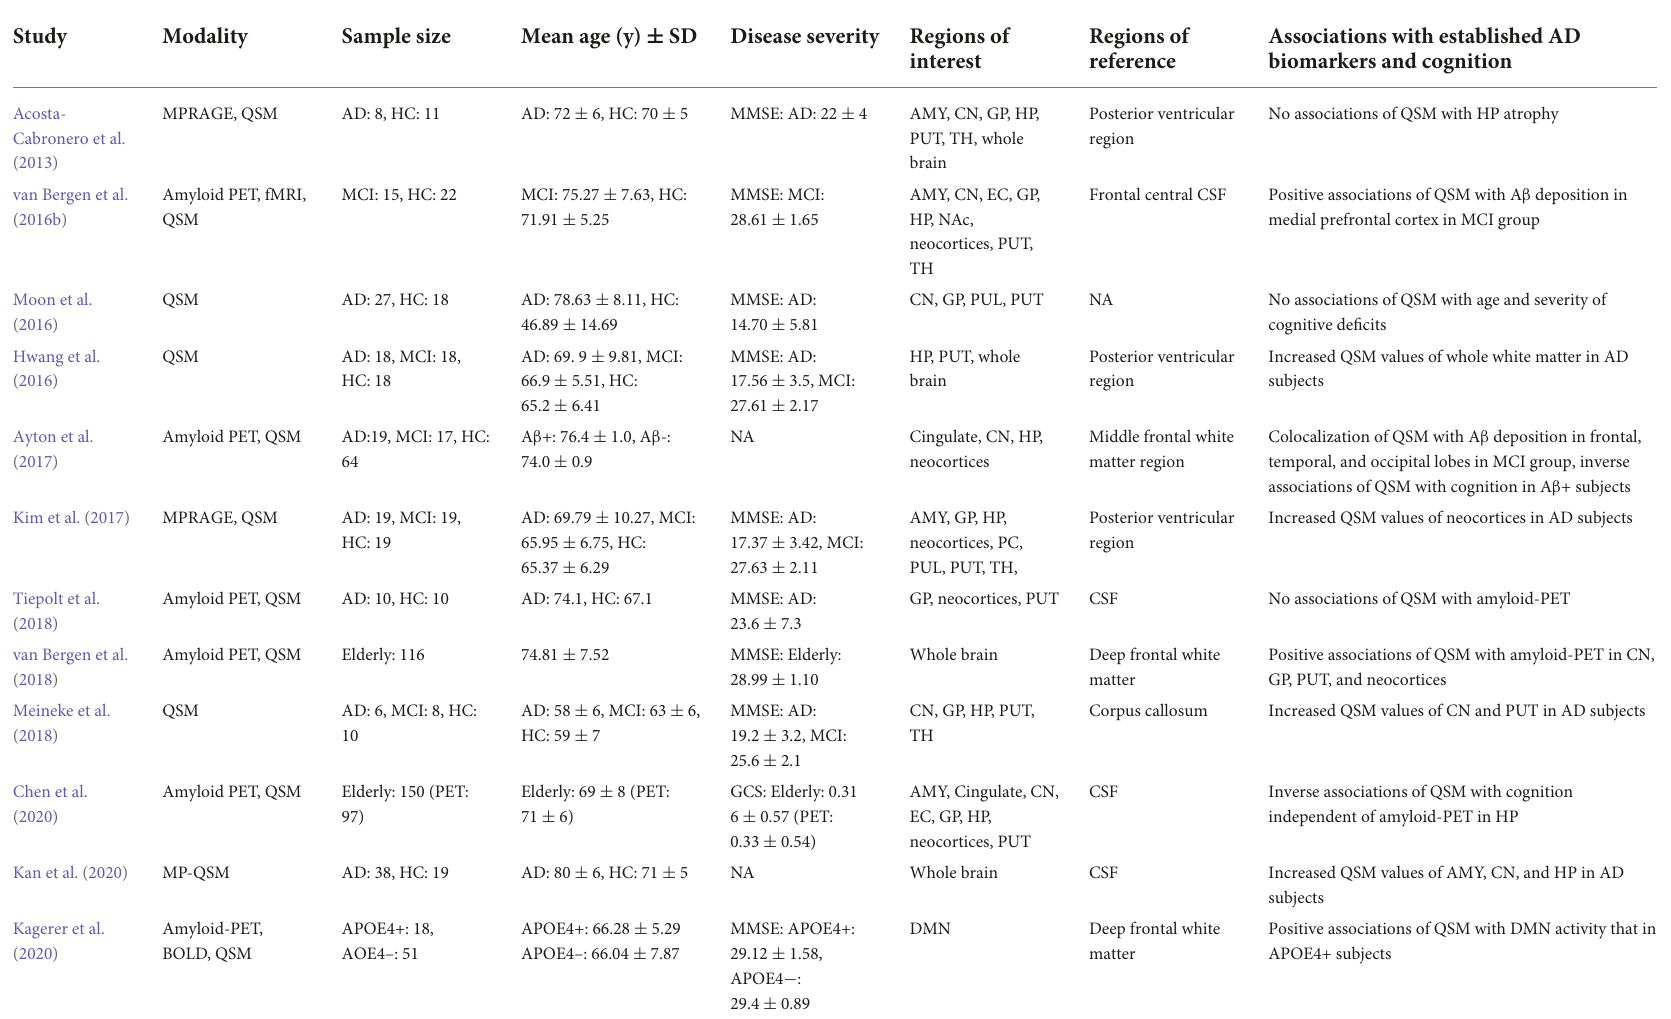
TABLE 2 Overview of QSM studies for AD continuum